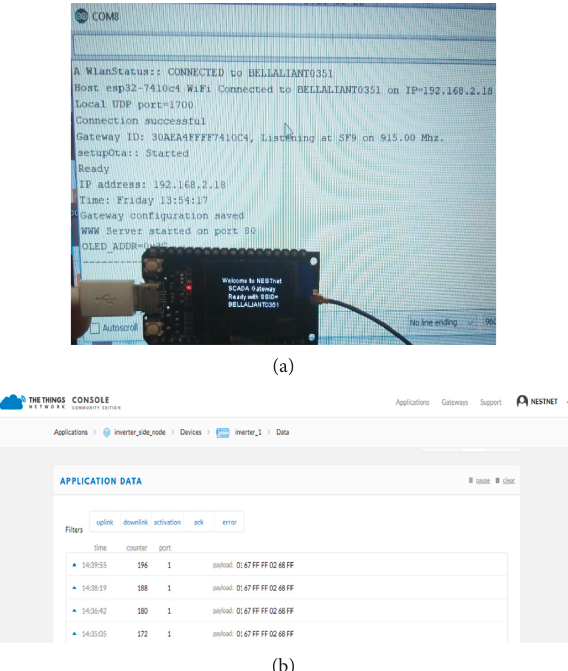
Figure 8: (a) Configuring ESP32 as a gateway. (b) Uploading data on The Things Network.